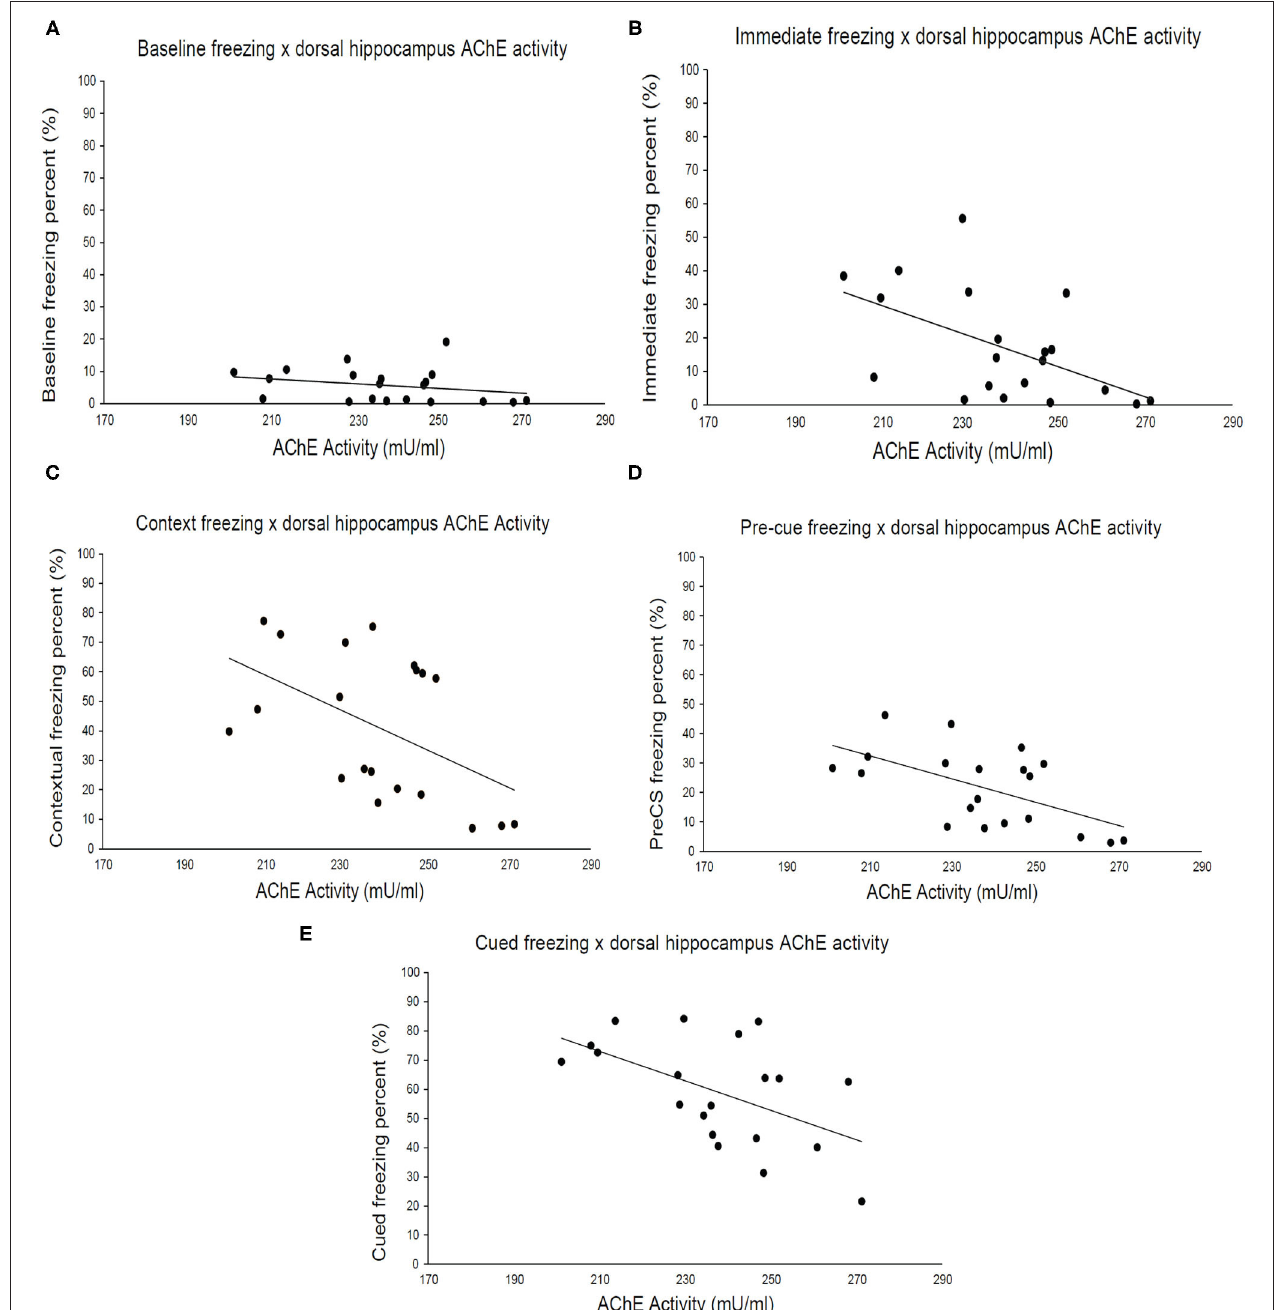
FIGURE 3 | Acetylcholinesterase activity in the dorsal hippocampus correlates with different fear learning components. (A) Baseline freezing has a weak correlation ( r = − 0.23, p > 0.05) with AChE activity in the dorsal hippocampus, whereas (B) immediate ( r = – p < 0.05), (C) context ( r = − 0.50, p < 0.05), (D) pre-cue ( r = − 0.58, p < 0.05), and (E) cued ( r = − 0.54, p < 0.05) freezing negatively correlate with AChE activity. Pearson correlations coefficients are presented in Table 1 , n = 20 total number of